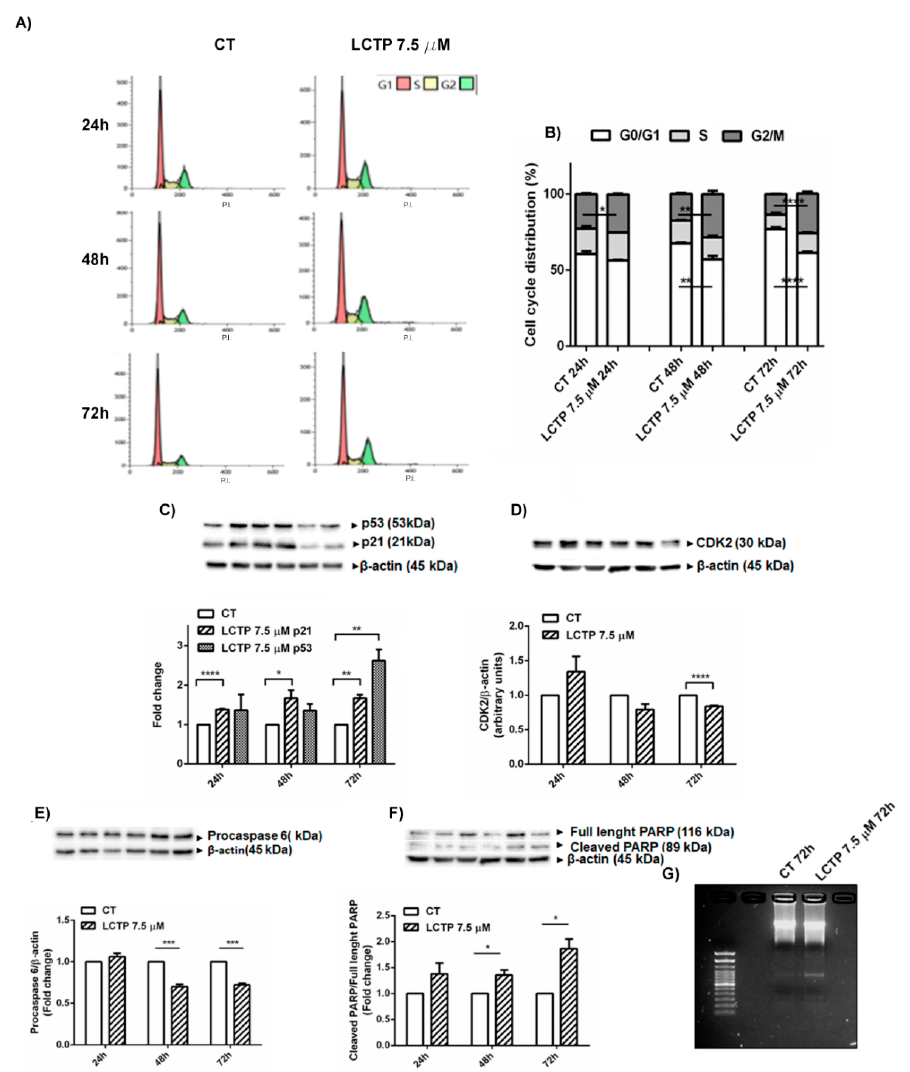
Figure 3. ( A ) Representative flow cytometry analysis of cell cycle arrest in G2 / M and ( B ) plot of cell cycle distribution of propidium iodide (PI) staining in U87Mg, vehicle (left panel) and LCTP (7.5 µM) treated cells (right panel) for 24, 48 and 72 h. Values are the means ± SEM of 3 individual determinations. * Unpaired t -test, p -value < 0.05. ( C ) Western blot analysis of p53 and p21 in long-term LCTP–treated U87Mg cells. Data were normalized to β -actin and are expressed as fold change over control-treated cells of 3 individual determinations. * Unpaired t -test, p -value < 0.05. ( D ) Western blot analysis of